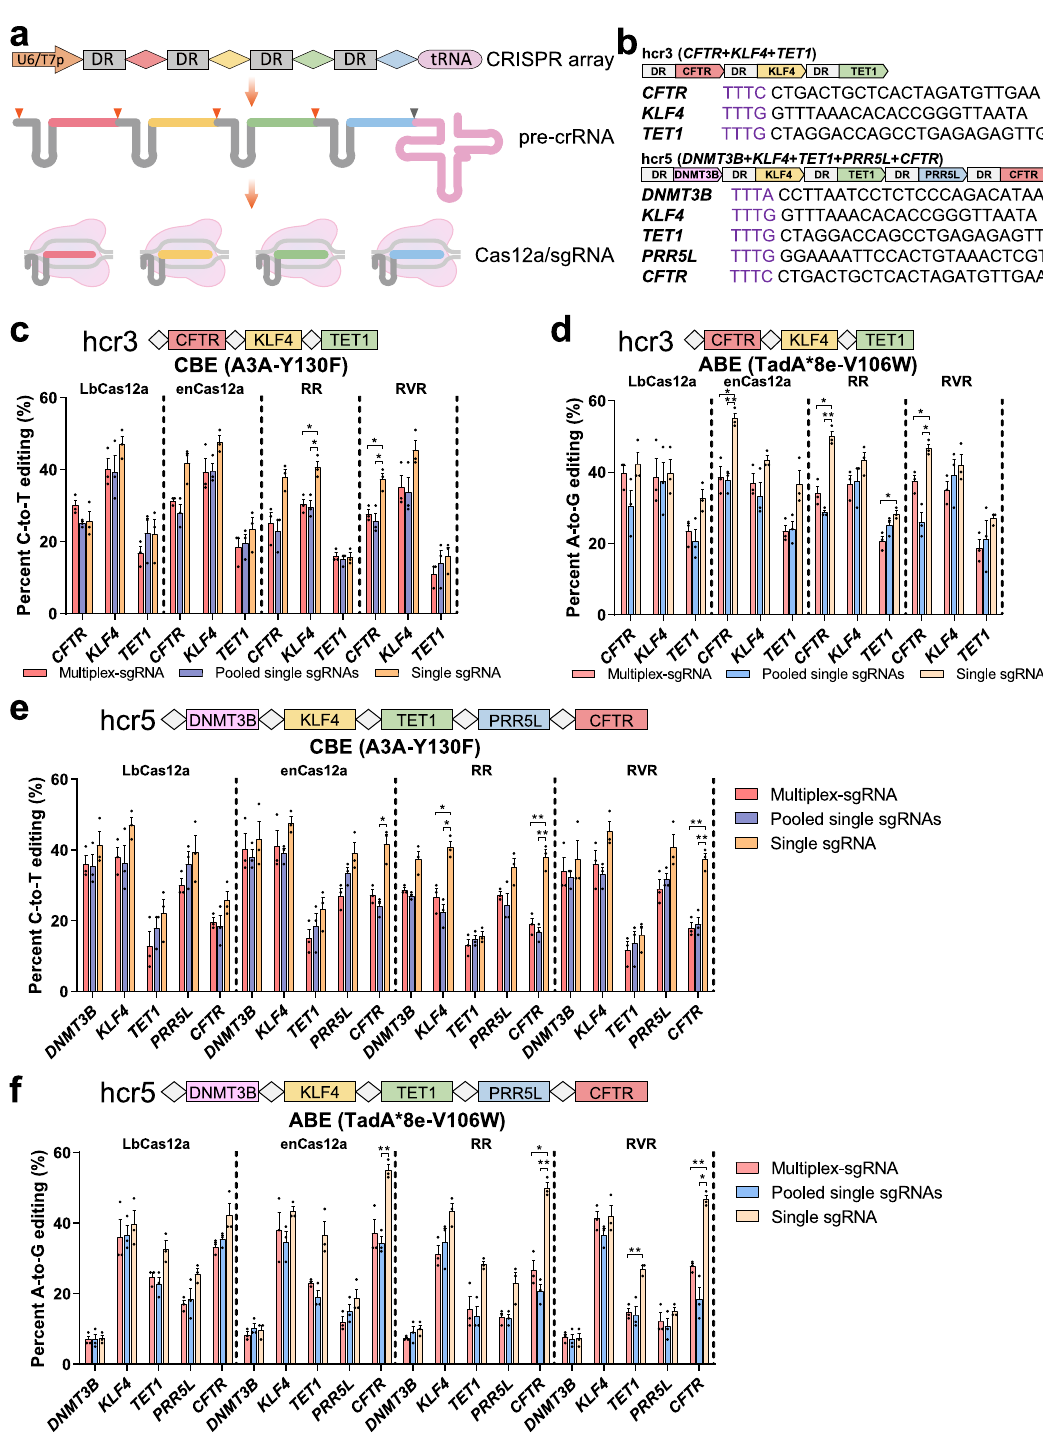
Fig. 3 Multiplexed base editing by Cas12a variant-mediated base editors in HEK293T cells. a Schematic illustrating a single CRISPR array processed by Cas12a per se to generate multiple mature sgRNAs for simultaneous multiple loci editing. A tRNA precursor sequence appended to downstream of the array is transcribed along with pre-crRNA and cut by RNase P as previously reported 51 . Rhombuses with distinctive colors indicate individual spacers. Orange and gray triangles denote the cleavage sites of Cas12a and RNase P, respectively. U6/T7p U6 or T7 promoter; DR direct repeat sequence; tRNA transfer RNA. b Constructs of CRISPR arrays of hcr3 with three tandem sgRNAs and hcr5 with fi ve tandem sgRNAs targeting to human genome. The sequences of individual targets are listed below, and PAMs are marked in purple. Simultaneous base editing of three loci ( CFTR , KLF4 , and TET1 ) in HEK293T cells by Cas12a variant-mediated CBEs ( c ) and ABEs ( d ) with multiplex-sgRNA (CRISPR array hcr3) or pooled single sgRNAs, with a single sgRNA for a single locus as the control ( n = 3). Simultaneous base editing of fi ve loci ( DNMT3B , KLF4 , TET1 , PRR5L , and CFTR ) in HEK293T cells by Cas12a variant-mediated CBEs ( e ) and ABEs ( f ) with multiplex-sgRNA (CRISPR array hcr5) or pooled single sgRNAs, with a single sgRNA for a single locus as the control ( n = 3). Values and error bars for c – f represent the mean and SEM, respectively. Statistical signi fi cance was calculated by Welch ’ s ANOVA test, and Tamhane ’ s T2 multiple comparisons test was performed. ns (not signi fi cant, p ≥ 0.05) is not shown, and only p < 0.05 is shown (* p < 0.05, ** p <